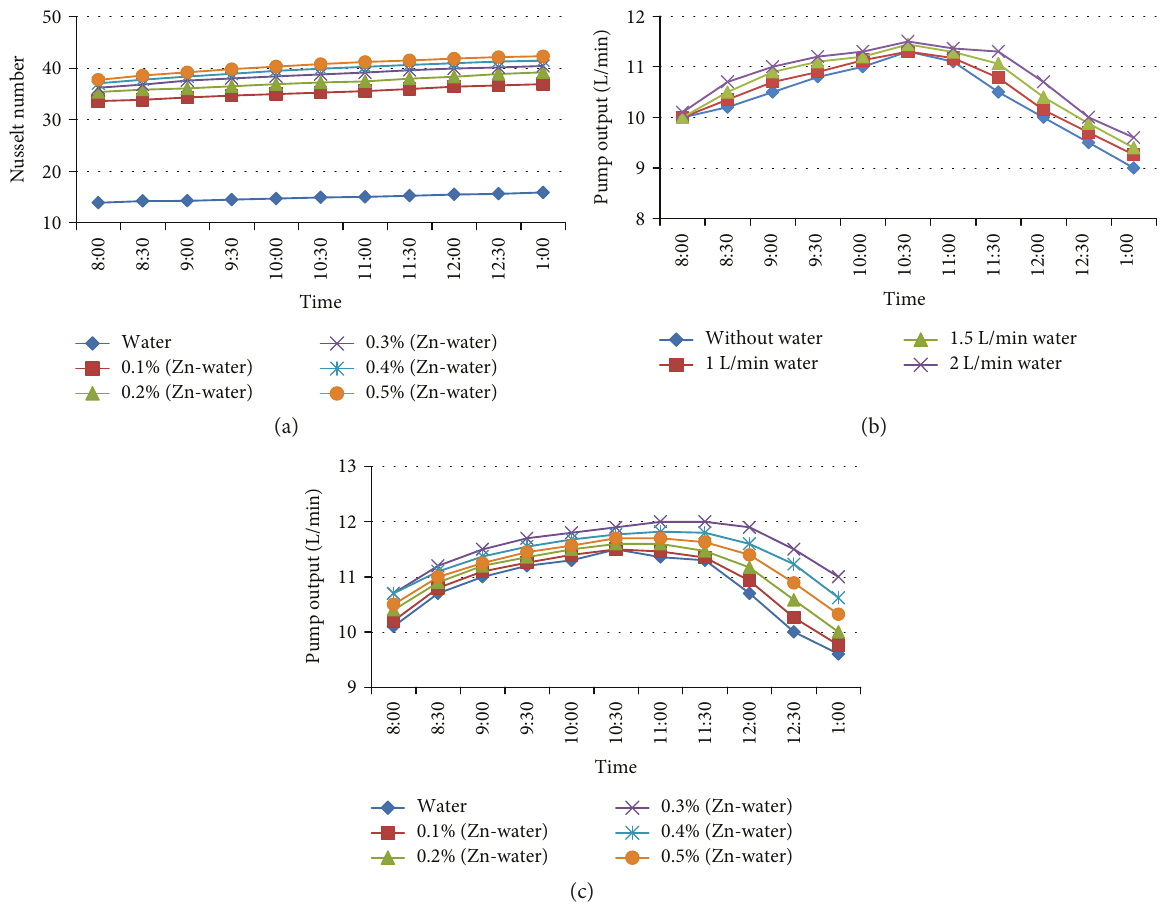
Figure 13: E ff ect of Zn-H O nano fl uid at 2 L/min on (a) Nusselt number, (b) pump output at di ff erent mass fl ow rates, and (c) pump output 2 at constant mass fl ow rate (2 L/min) with di ff erent concentration